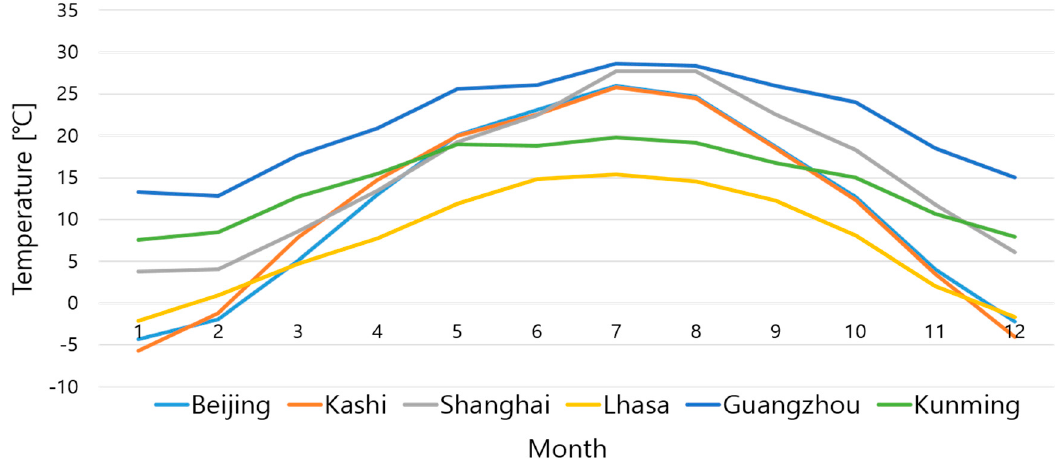
Figure 6. Comparison of outdoor temperatures of the selected cities.